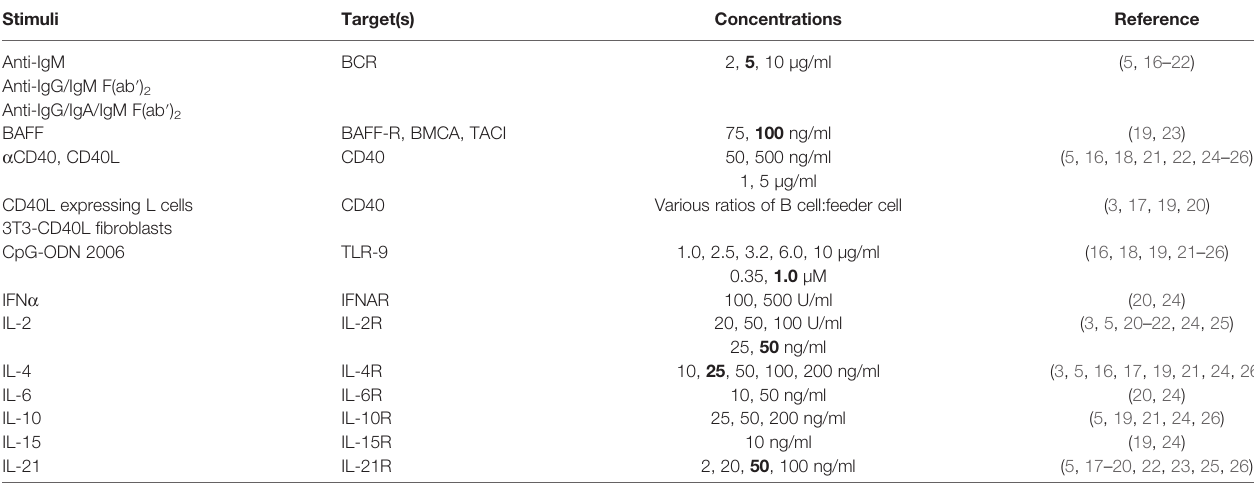
TABLE 1 | Frequently reported B-cell differentiation stimuli for human naive and/or memory B cells in